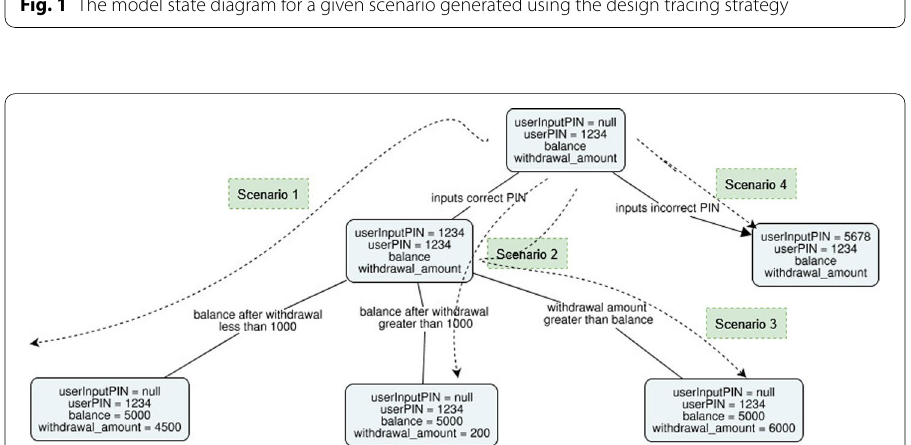
Fig. 2 The scenario branching tree for a given